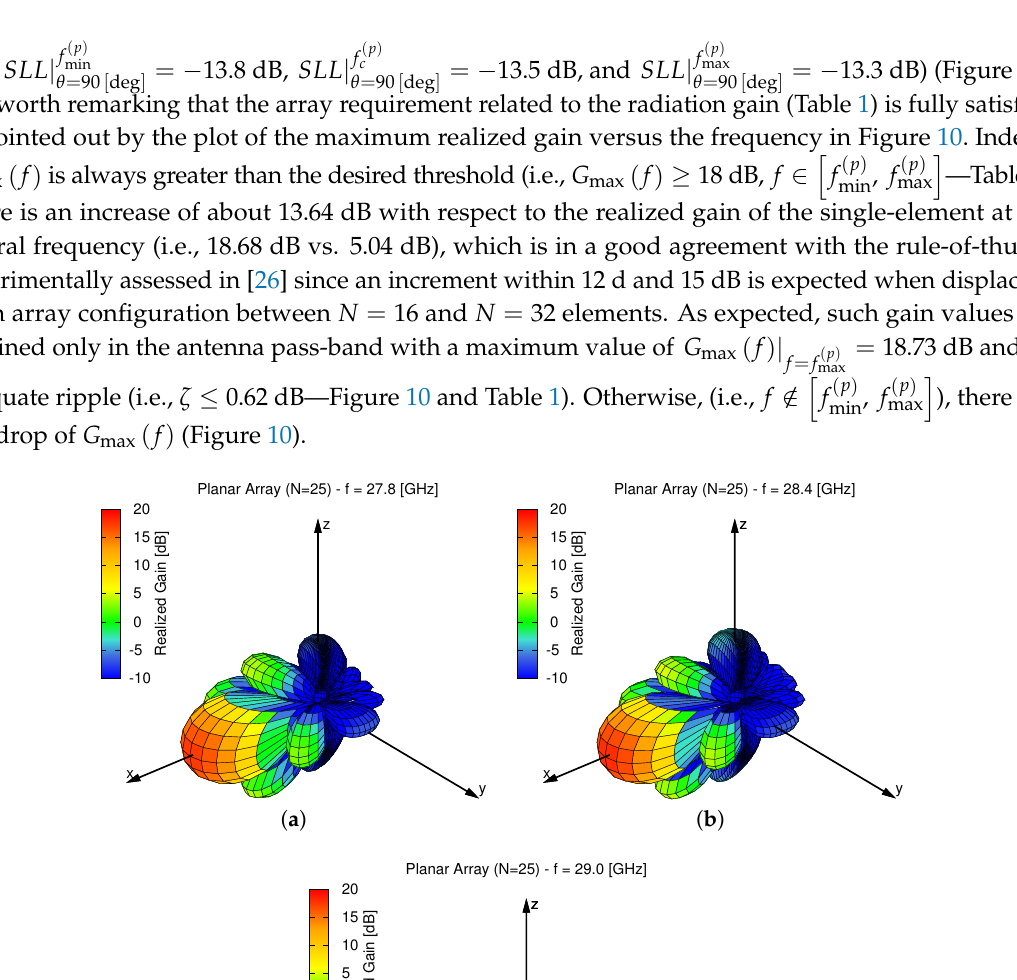
(cid:105) (cid:104) ( p ) ( p ) = [ 27.8, 29.0 ] (GHz))—3D plot of realized f , f max min ( p ) ( p ) c ; and ( c ) f max